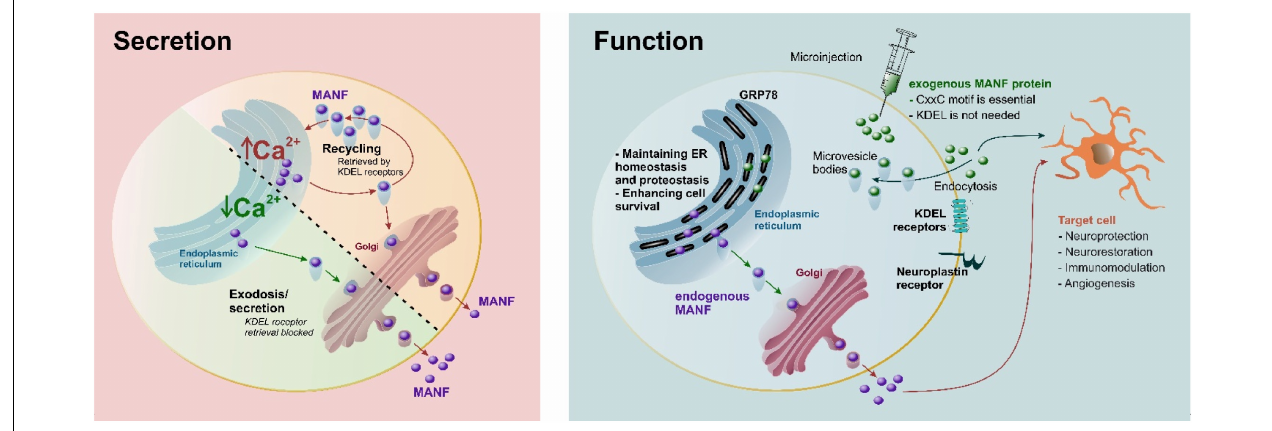
FIGURE 3 | Secretion and proposed function of MANF. Under normal conditions, MANF is maintained in the endoplasmic reticulum (ER) by KDEL receptor-mediated retrieval and secreted in response to Ca 2 + depletion. MANF maintains ER homeostasis and proteostasis, as well as enhances cell survival. A CxxC-motif is essential for neuroprotection for both endogenous and exogenous MANF, while the C-terminal RTDL sequence of MANF (corresponding to the canonical KDEL ER-retrieval signal) is not needed for the neuroprotective effect of exogenous MANF (Matlik et al., 2015). It is possible that KDEL and neuroplastin receptors may participate in internalization of extracellular MANF, and interaction with sulfatides may be important for internalization. It should be emphasized the majority of KDEL receptors are in the Golgi, and only a fraction of them can be at the plasma membrane at any given time point. Purple circles, endogenous MANF; green circles, recombinant exogenous